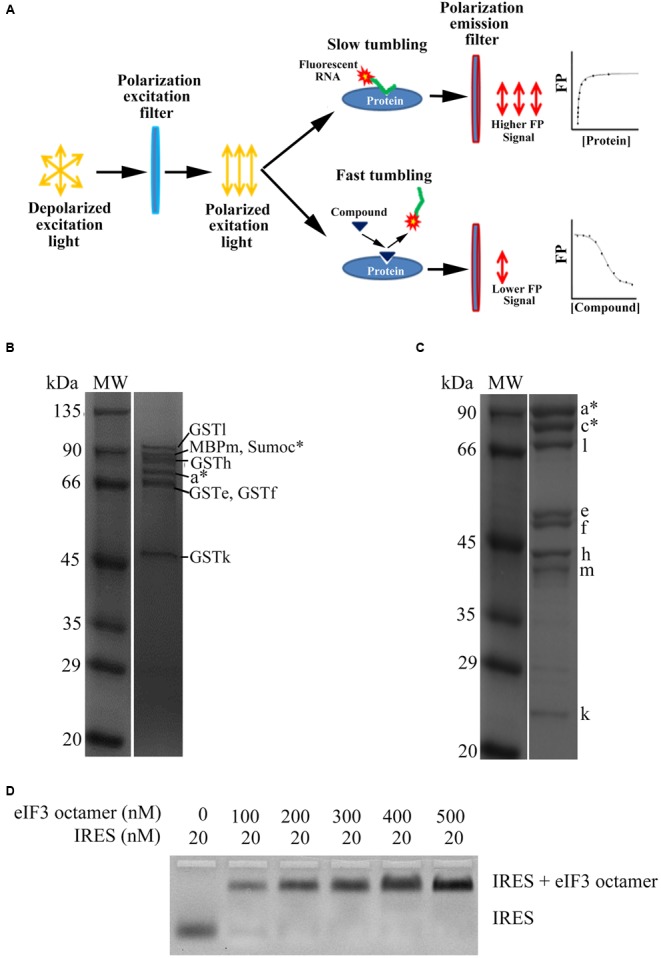
Purification of human eIF3 octamer and binding assays of eIF3 octamer with HCV IRES. (A) The schematic diagram of fluorescence polarization based on the interaction between protein and fluorescent labeled RNA. (B) Coomassie stained SDS-PAGE gel analysis of purified eIF3 octamer with affinity tags. Molecular weight (MW) markers are shown in kilodaltons. (C) Coomassie stained SDS-PAGE gel analysis of cleaved eIF3 octamer. MW markers are shown in kilodaltons. (D) Native agarose gel showing binding of the eIF3 octamer to the HCV IRES. The nanomolar concentrations of the octamer and HCV IRES are listed. The reactions were carried out in the presence of 2 μM tRNA to prevent non-specific binding.